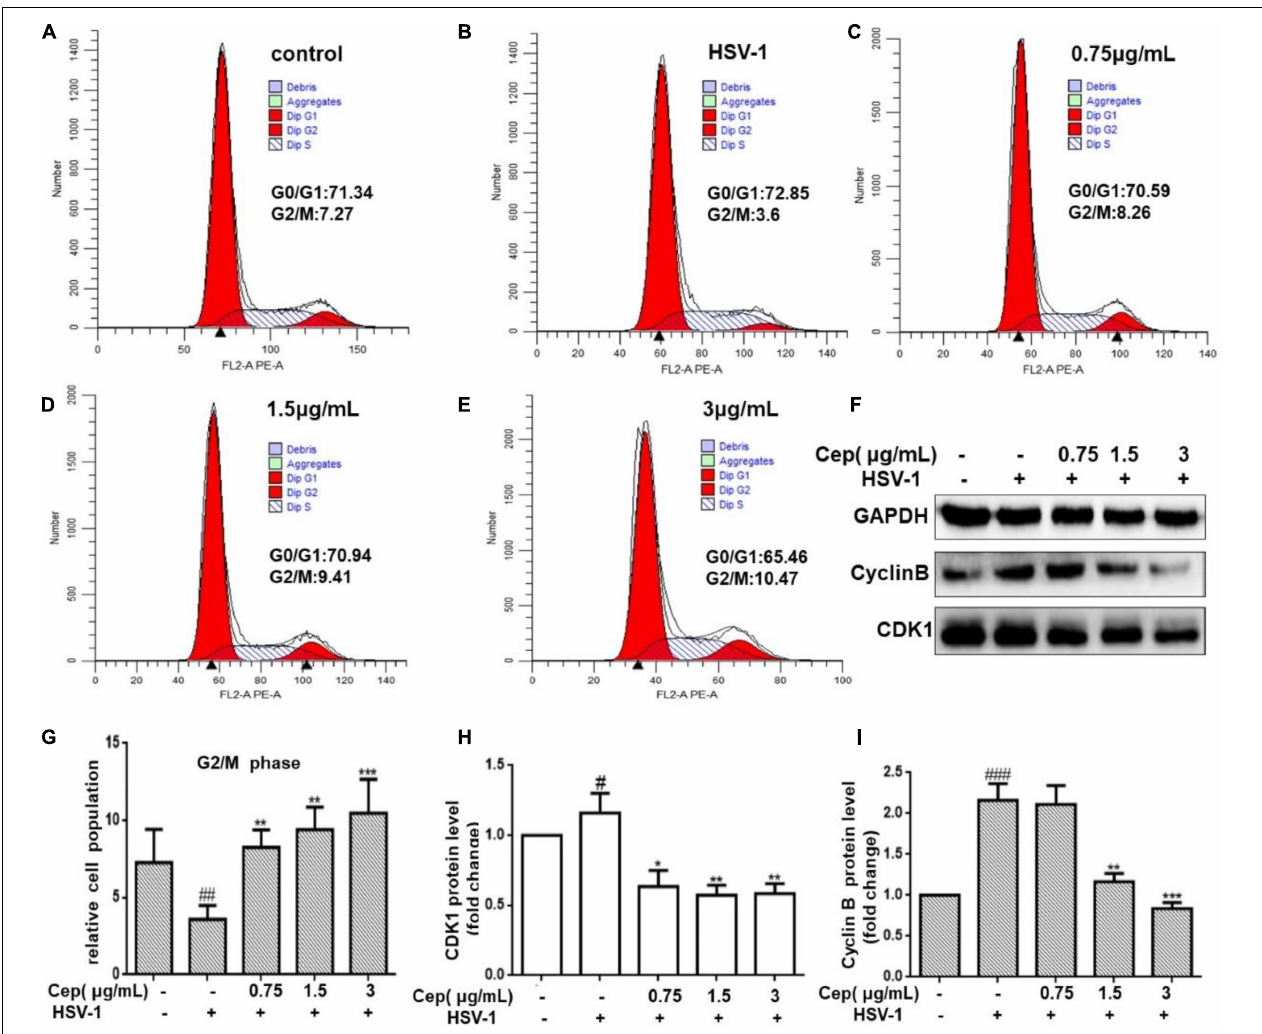
FIGURE 6 | The effect of CEP on the cell cycle of infected cells. (A–E) HSV-1 (MOI = 1) infected Hela cells were treated with CEP (3, 1.5, and 0.75 µ g/mL) for 36 h. Cells were collected and cell cycle were analyzed by flow cytometry. (F) HSV-1 (MOI = 1) infected Hela cells were treated with CEP (3, 1.5, and 0.75 µ g/mL) for 36 h. Cell lysates were collected for Western blotting as indicated. (G–I) Results from three independent experiments were quantitated and presented as means ± SD. # P < 0.05; ## P < 0.01; ### p < 0.001 indicates significant difference vs. NC group; * P < 0.05; ** P < 0.01; *** P < 0.001 indicates significant difference vs. model